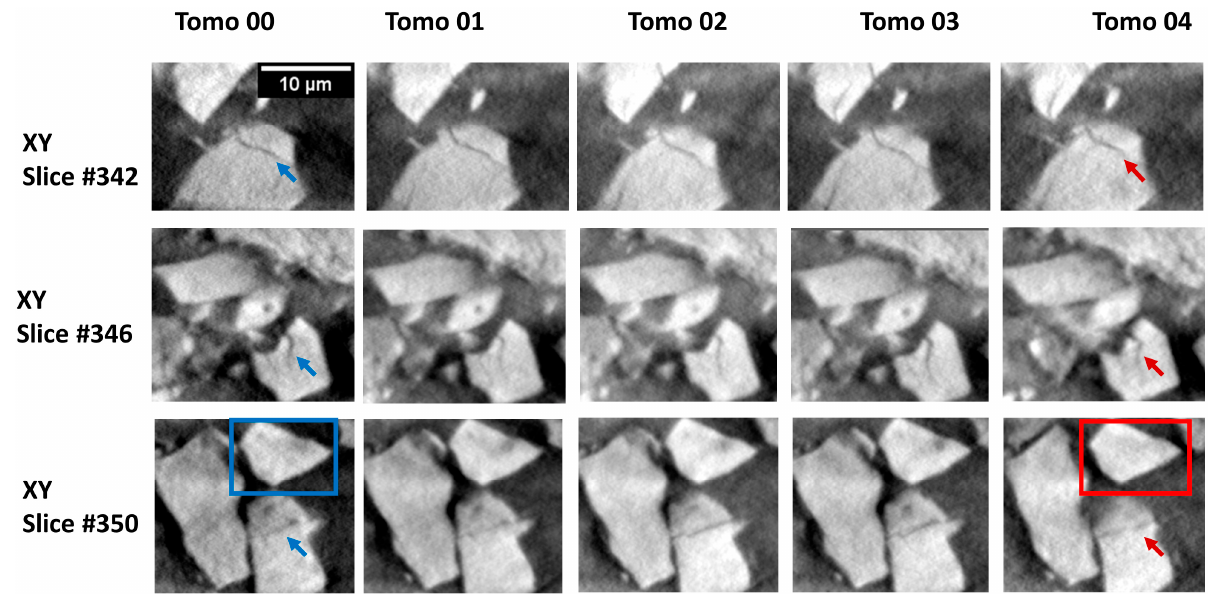
Figure 5. Virtual X-ray tomography cross-sections. Arrows mark medium-sized and less dense particles that already had microcracks in the as-prepared material, but did not show any evolution. Rectangles mark a smaller, dense particle that did not show any cracks during the experiment.